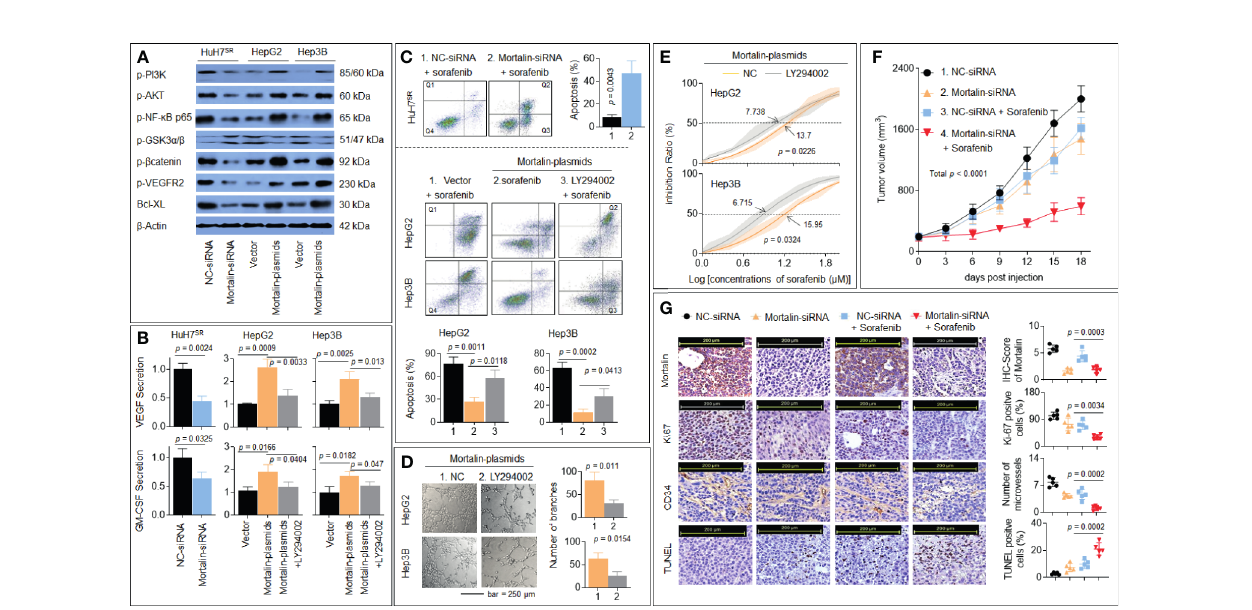
FIGURE 4 | Veri fi cation of microarray and bioinformatics results in vitro and in vivo . (A) HuH7 SR cells were transfected with mortalin-siRNA, and HepG2 and Hep3B cells were transfected with mortalin-plasmids. Western blotting assay and quantitative analyses of the expression of phosphatidylinositol 3-kinase (PI3K)-p85 (Tyr458), Akt (Ser473), nuclear factor (NF)- k B p65 (Ser536), vascular endothelial growth factor receptor (VEGFR)2 (Tyr951), glycogen synthase kinase (GSK)3 b (Tyr216), b -catenin (Thr41/Ser 45), and Bcl-XL. (B) HuH7 SR cells were transfected with mortalin-siRNA, and HepG2 and Hep3B cells were transfected with mortalin- plasmids, pretreated with LY294002, and the medium was collected. Triplicate ELISA analyses of VEGF and granulocyte-macrophage colony-stimulating factor (GM- CSF) protein secretion. (C) After transfection, these cells were treated with 10 m M sorafenib. Flow cytometric analyses of the percentage of cells in apoptosis (Q1: necrotic cells, Q2: late apoptosis, Q3: early apoptosis, Q4: living cells). From the histograms, the proportion of cells in total apoptosis (Q2 + Q3) was statistically analyzed. (D) Capillary tube formation assay analyses of mortalin-plasmid-transfected HepG2 and Hep3B cells, in the absence of LY294002, on tube formation in human umbilical vein endothelial cells (HUVECs); a quantitative analysis is shown. (E) Mortalin-plasmid-transfected HepG2 and Hep3B cells were treated with different concentrations of sorafenib for 24 h in the absence of LY294002. The cell viability was determined in triplicate, and the IC 50 values were calculated. (F, G) The HuH7 SR cell xenografts were treated with mortalin-siRNA alone, sorafenib alone, or sorafenib plus mortalin-siRNA. (F) The volumes of xenografted tumors. (G) Immunohistochemistry (IHC) staining of the mortalin, ki67, CD34, and terminal deoxynucleotidyl transferase biotin-dUTP nick end labeling (TUNEL) staining. The differences were analyzed using Student ’ s t -test and one-way analysis of variance followed by Dunnett ’ s t